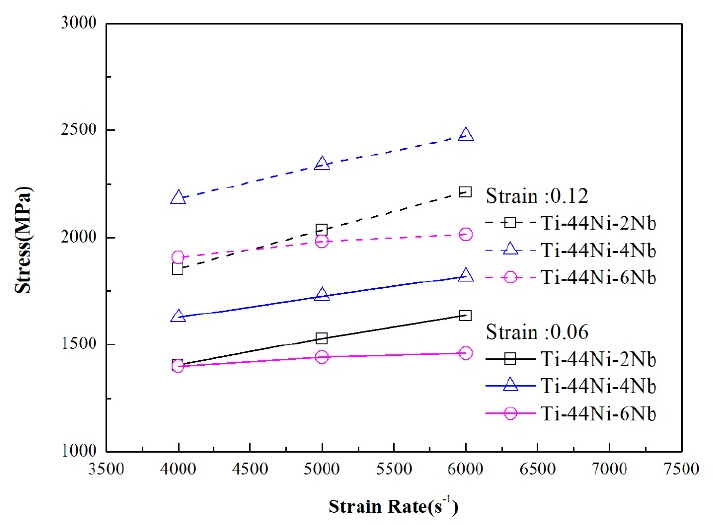
Figure 7. Variation of plastic flow stress with strain rate under dynamic deformation conditions.